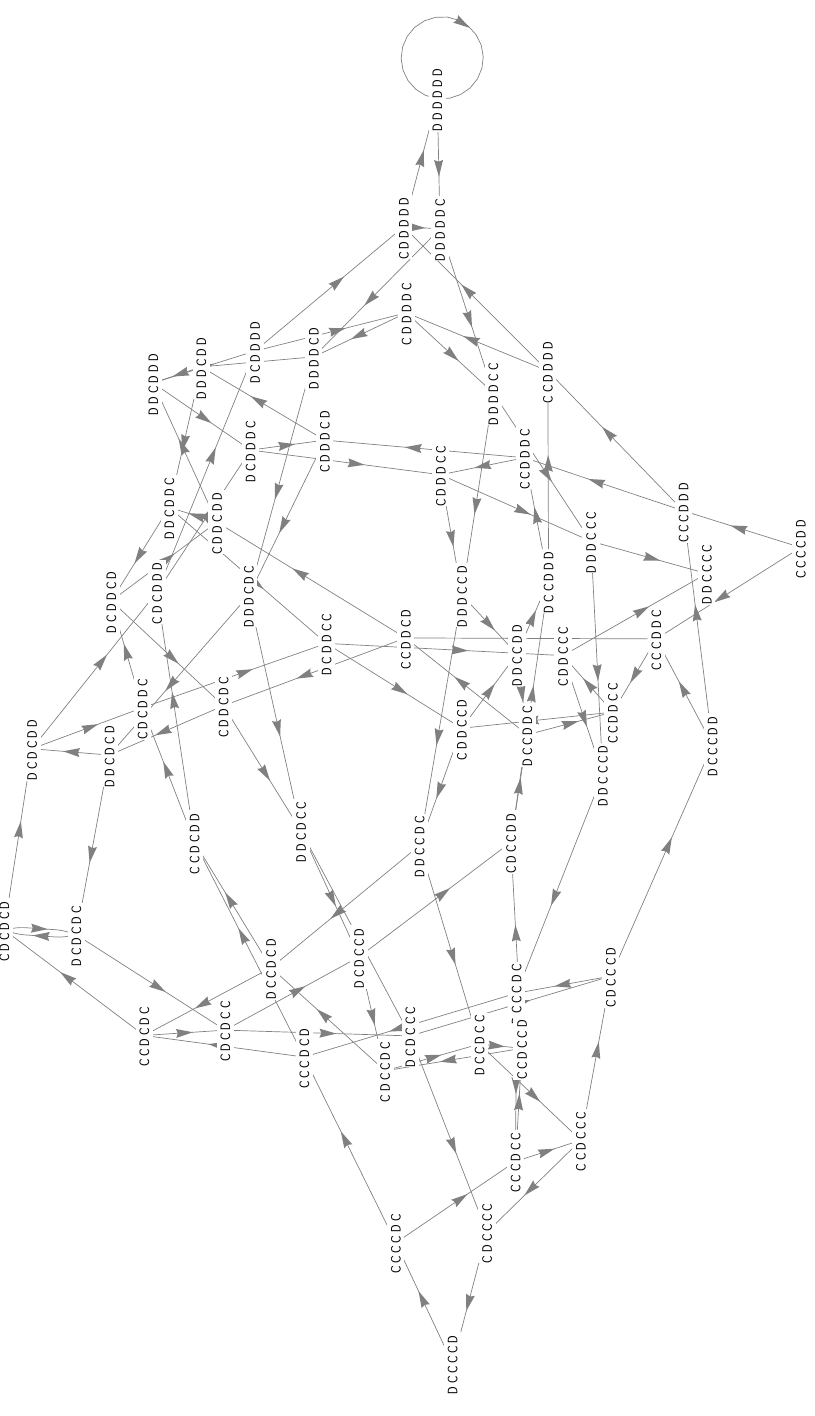
Figure 6: The digraph D used to compute the number of binary words of length 6 containing 6 the letters C and D which do not contain any of the substrings mentioned in Theorem